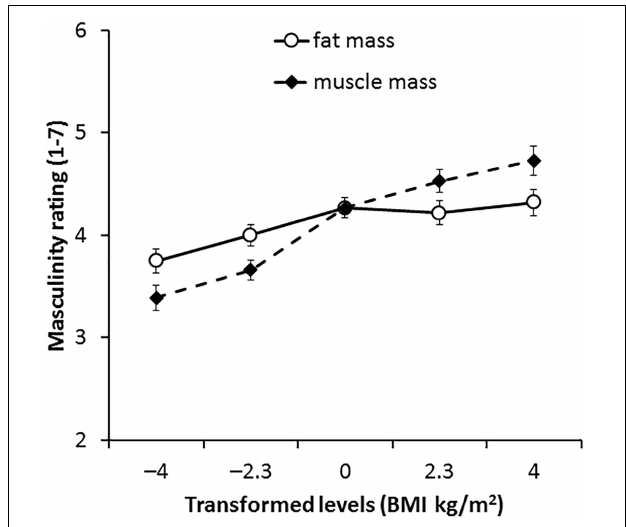
FIGURE 6 | Average masculinity ratings for faces transformed with the face shape correlates of fat and muscle mass for the independent 2D face set. Error bars represent the standard